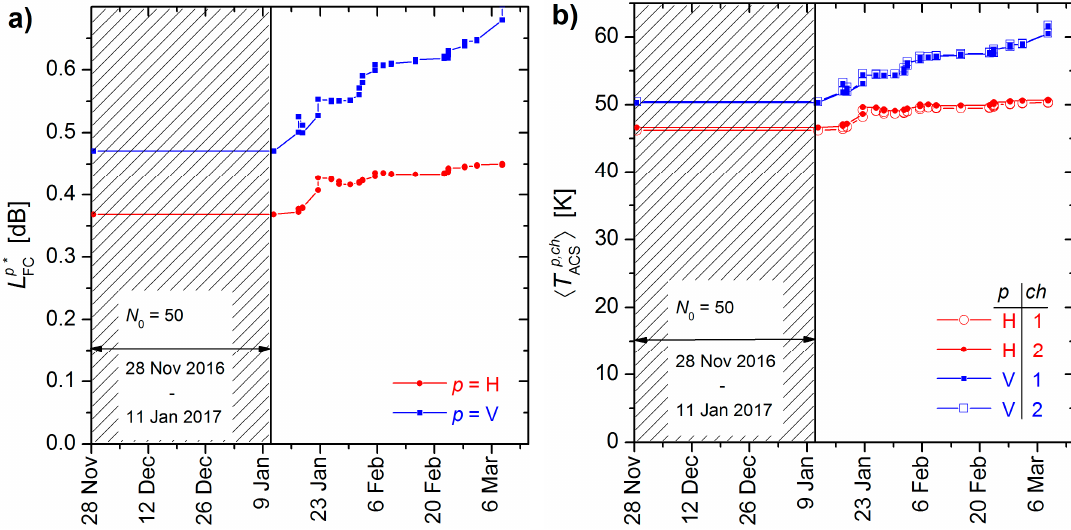
∗ and ( b ) (cid:104) T p , ch ∗ (cid:105) ( ch = 1, 2 and p = H, V) computed with increasing numbers Figure 8. ( a ) Effective L p Figure 8. ( a ) Effective (cid:1838) (cid:2904)(cid:2896)(cid:3043) and ( b ) 〈(cid:1846) (cid:2885)(cid:2887)(cid:2903)(cid:3043),(cid:3030)(cid:3035) 〉 ( ch = 1, 2 and p = H, V) computed with increasing TL ACS of sky numbers of sky measurements.